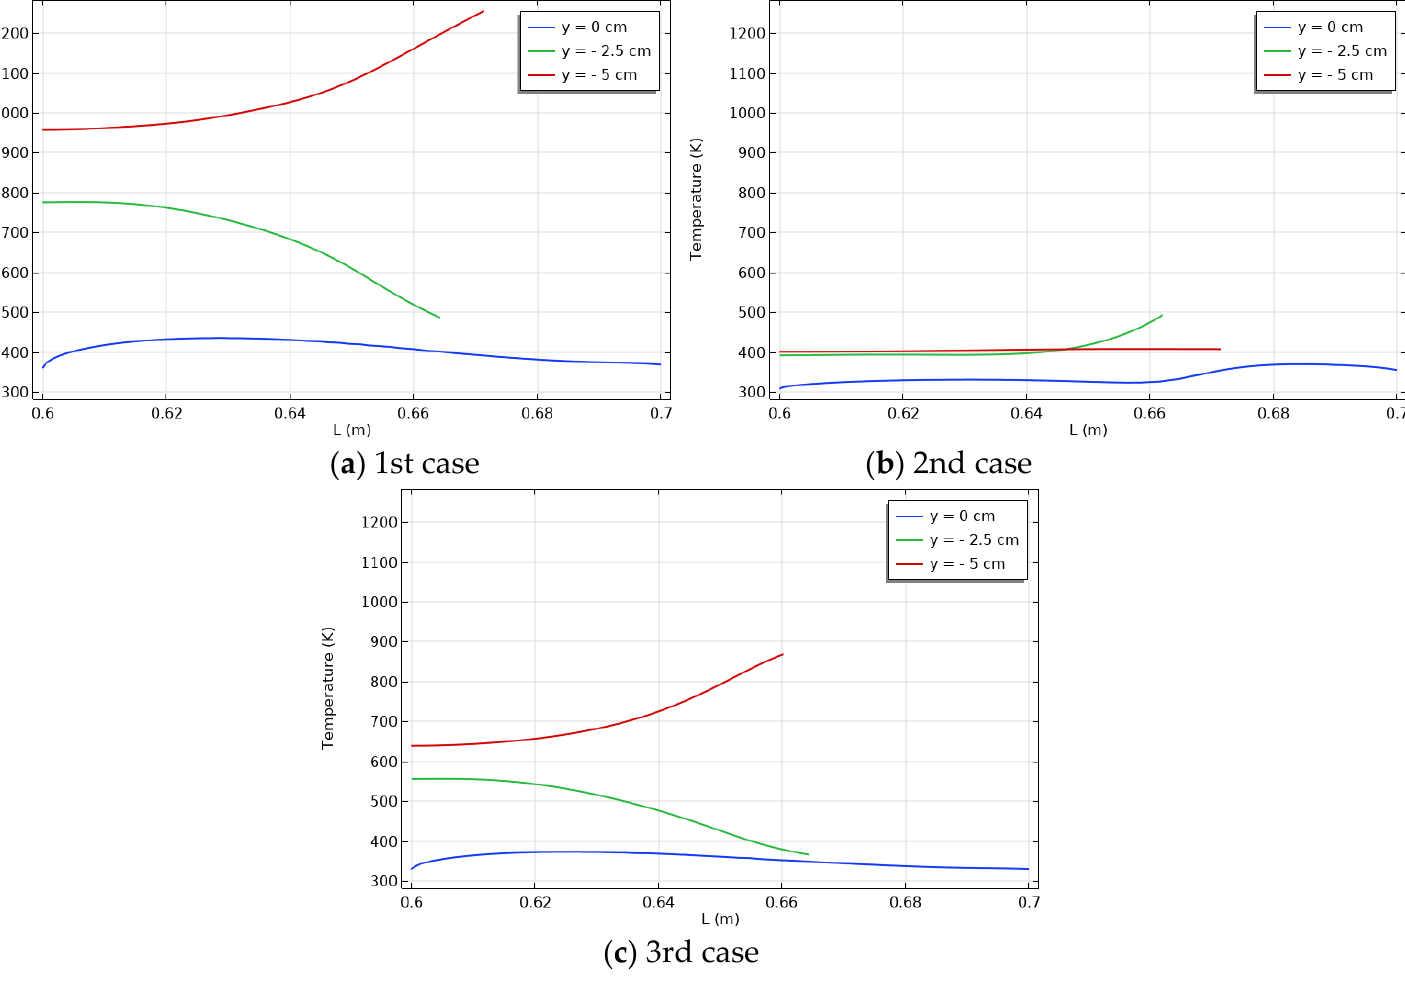
Figure 12. Temperature profile during the negative y axis in the cavity .